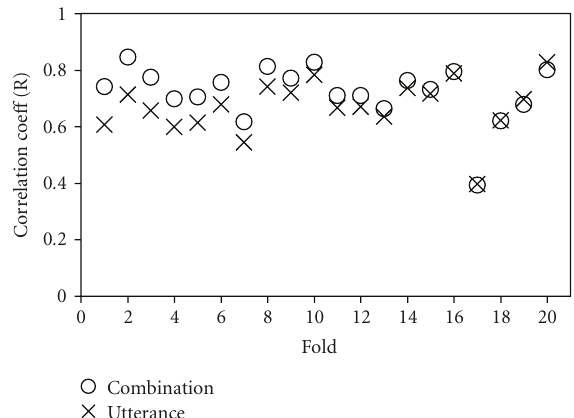
Figure 5: Correlations with perceived level of certainty per fold for the combination (O) and the utterance (X) feature set predictions, sorted by the size of the di ff erence. In 16 of the 20 experiments, the correlation coe ffi cients for the combination feature set are greater than those of the utterance feature